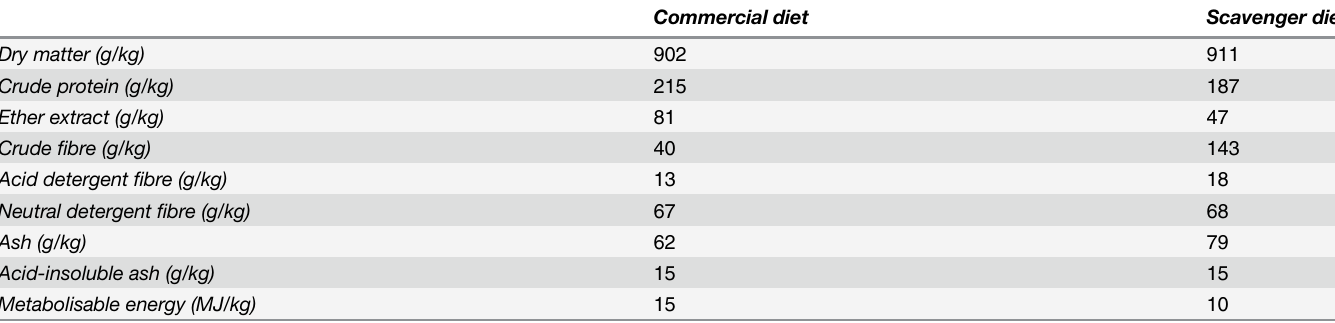
Table 1. Nutrient and energy concentration of both test diets: commercial and scavenger